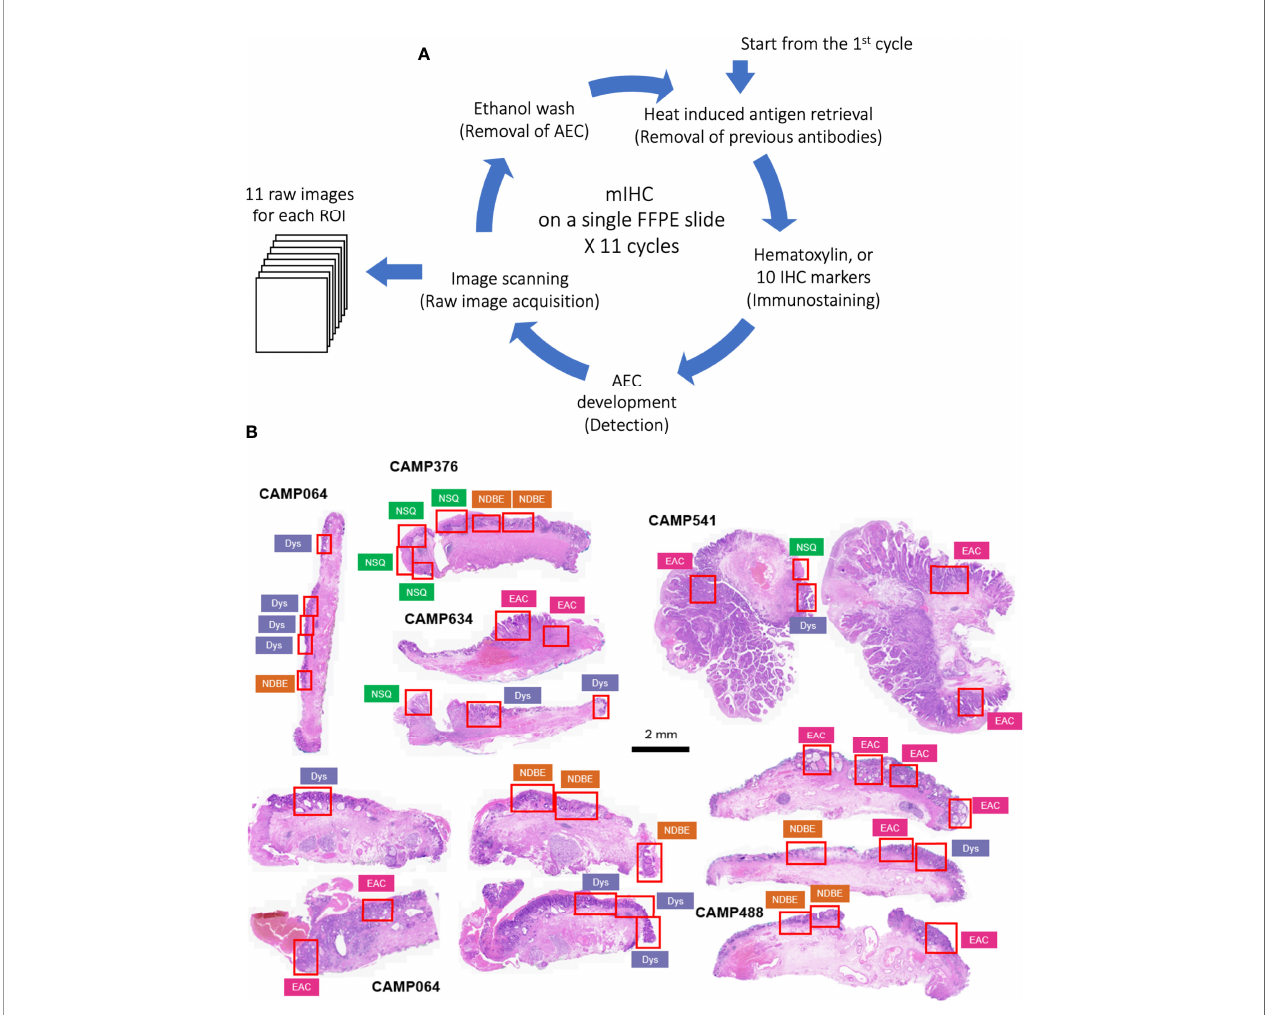
FIGURE 1 | (A) Schematic of staining cycles of mIHC; (B) H&E image of EMR tissue cohort and ROIs of different disease grades. NSQ, normal squamous esophagus; NDBE, non-dysplastic Barrett ’ s esophagus; Dys, dysplasia; EAC, esophageal